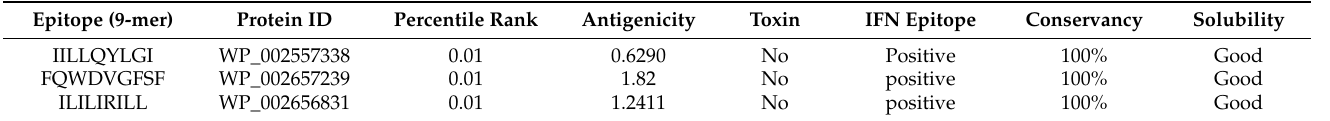
Table 3. A shortlist of HTL epitopes to be used in the final vaccine